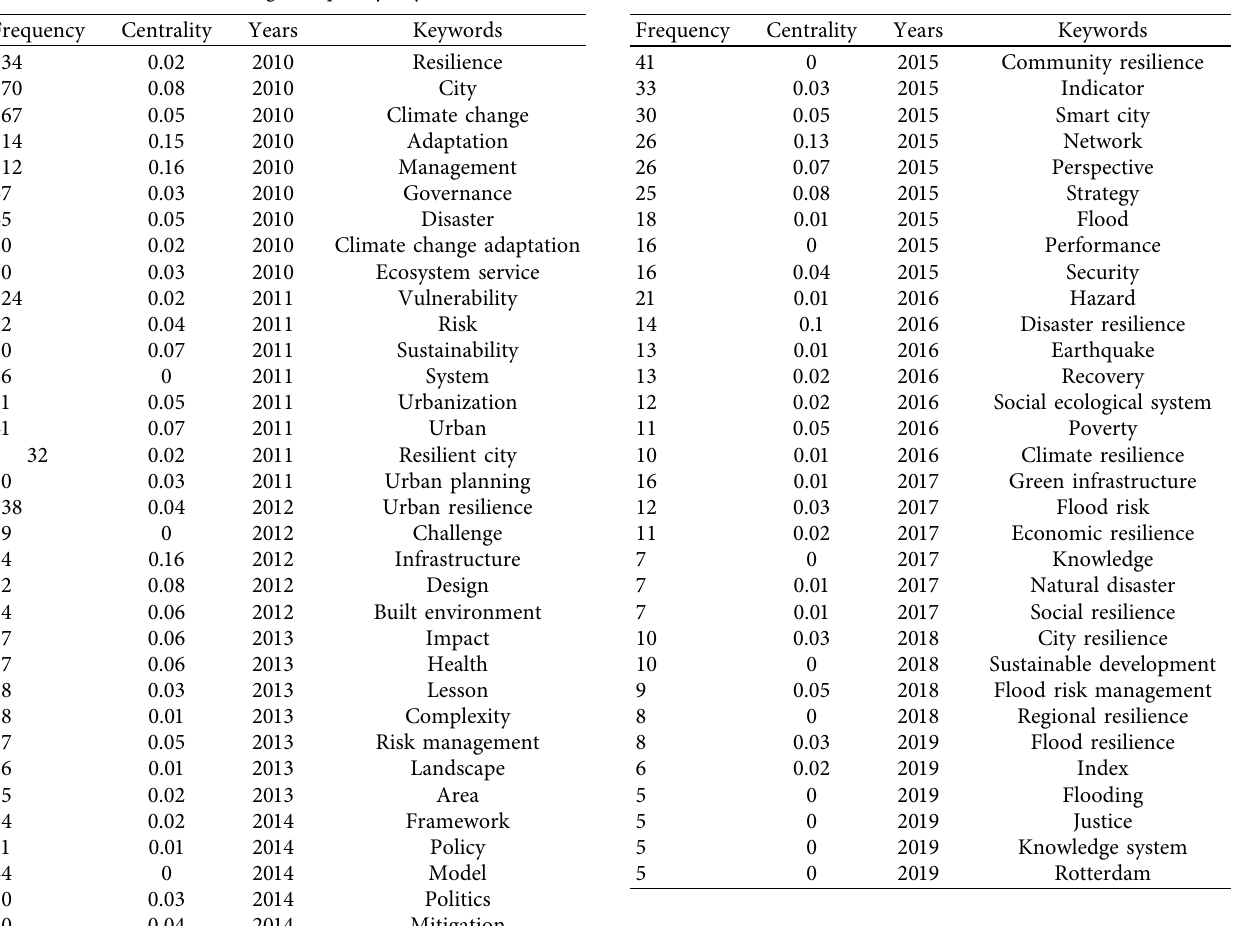
Table 7: Annual high-frequency